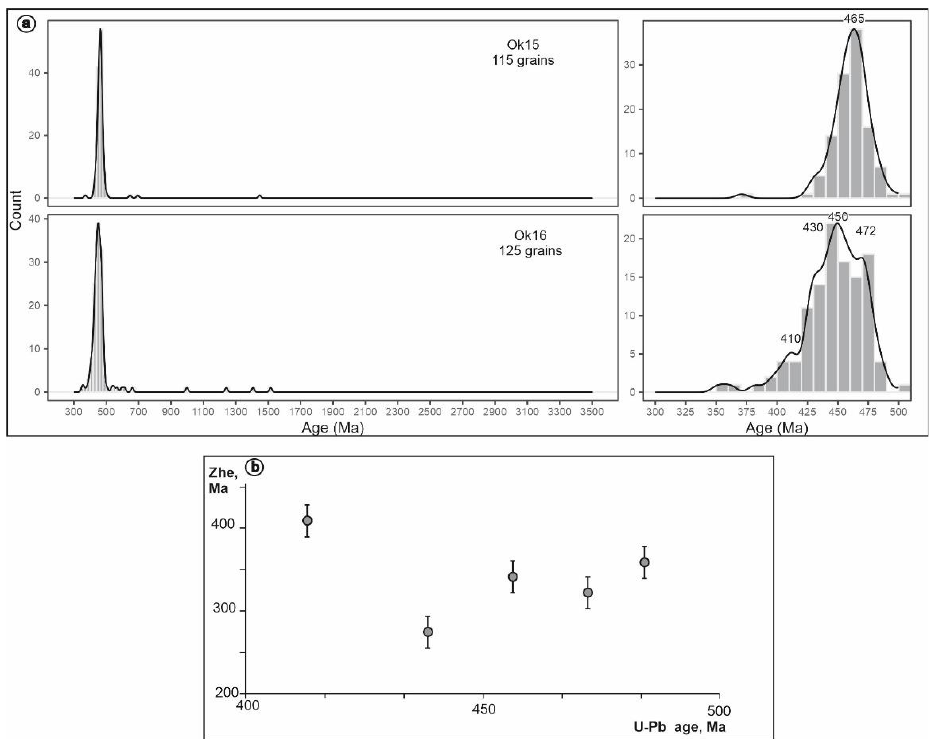
Figure 5. Kernel Density Estimation (KDE) plots depicting the U-Pb detrital zircon data ( a , b ) double-dated (U-Pb and (U-Th)/He) zircons from the Upper Carboniferous – Lower Permian strata of north-eastern October Revolution Island.